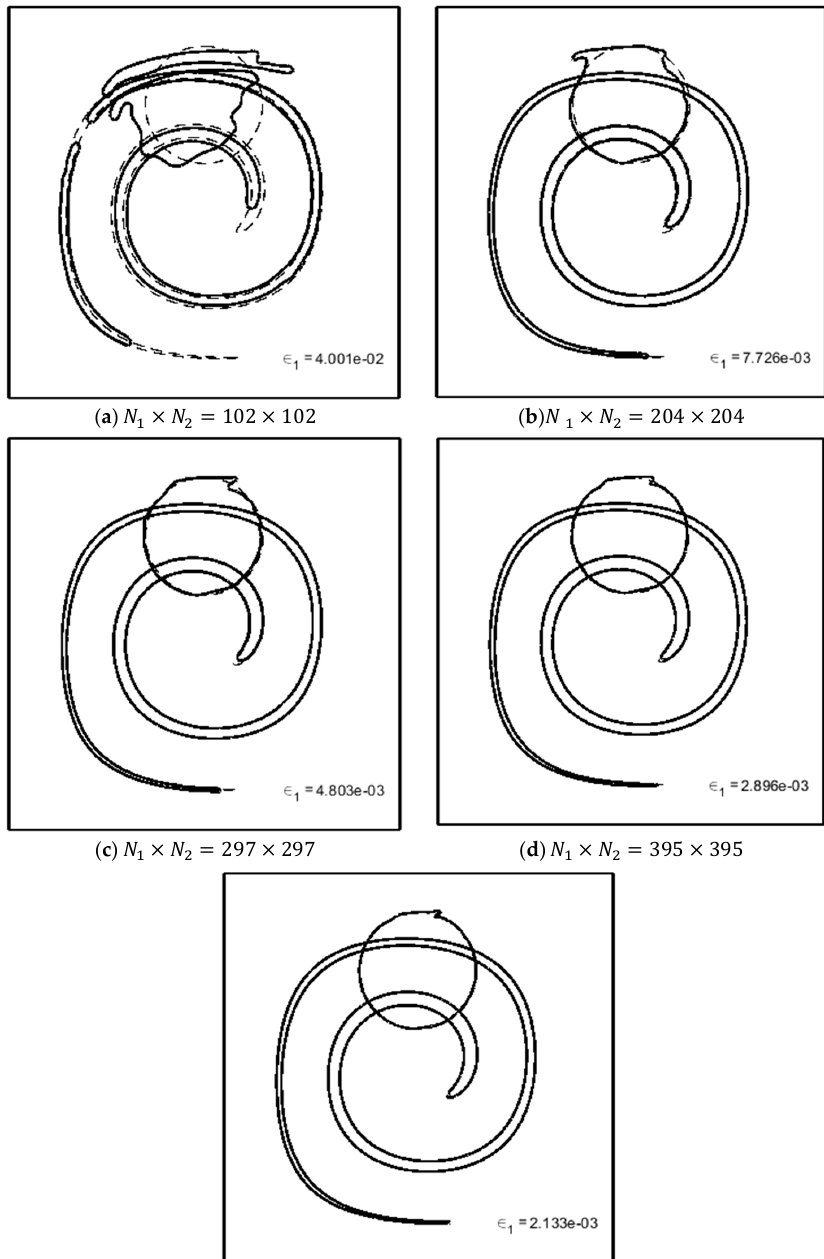
Figure 15. The interface shape in swirling flow vortex at t = 4 and t = 8 for unstructured meshes with different spacing. The values of the (cid:101) 1 norm is also